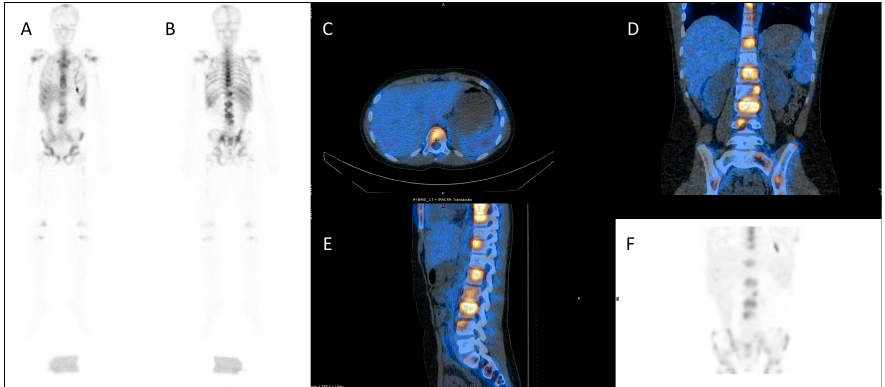
Figure 4. Dosimetry imaging with 111 In-labelled anti-CD66 monoclonal antibody in a patient with relapsed leukaemia prior to 90 Y anti-CD66 monoclonal therapy in an early phase trial [50]. ( A ) Anterior and ( B ) posterior whole-body planar scintigraphy views; ( C ) axial, ( D ) coronal and ( E ) sagittal fused SPECT CT views; and ( F ) SPECT maximum intensity projection image. These demonstrate avid uptake in areas of involved bone marrow.